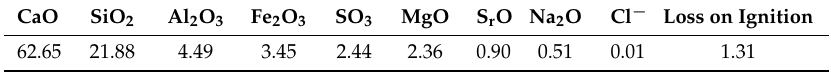
Table 1. Chemical compositions of ordinary Portland cement (OPC) (% by mass).